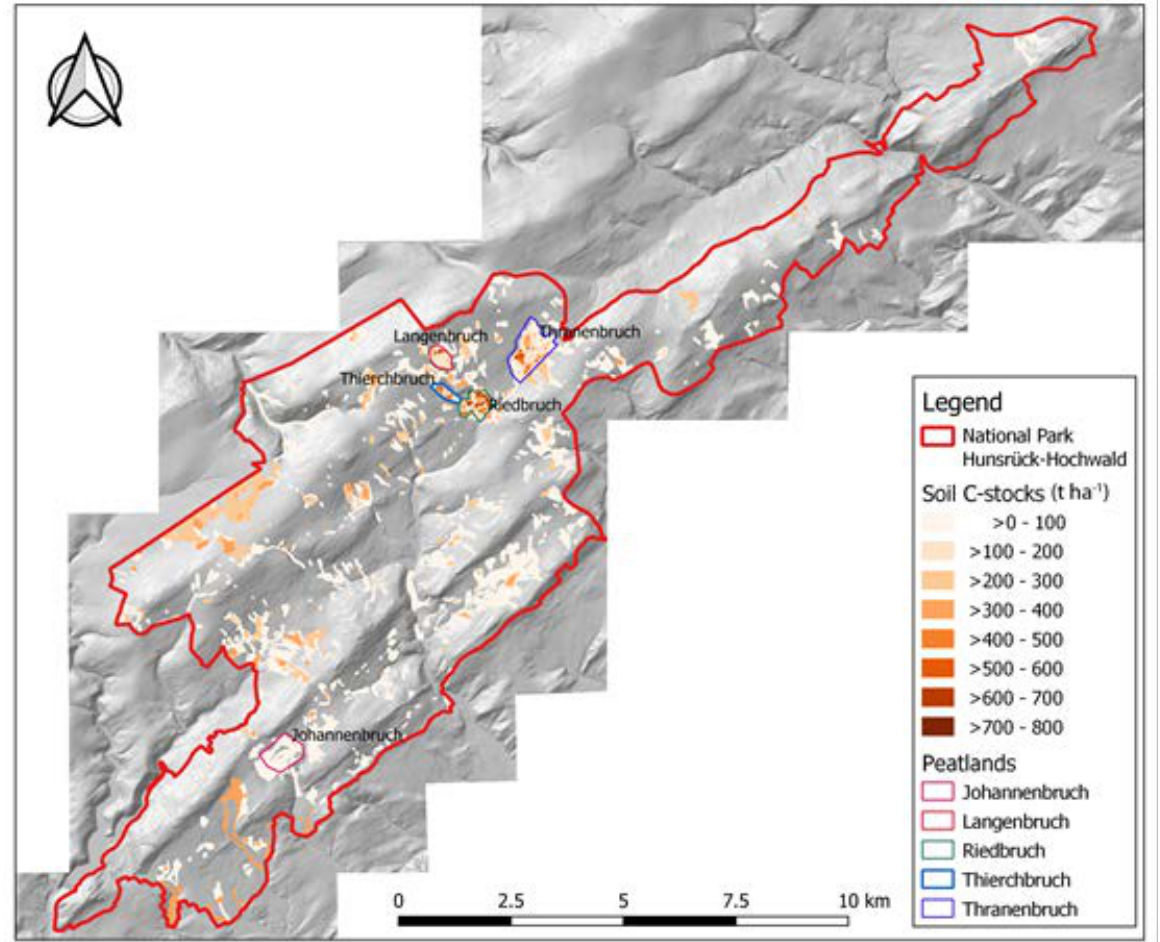
Figure 9. Extrapolation map of soil carbon stocks at the National Park Hunsrück-Hochwald.